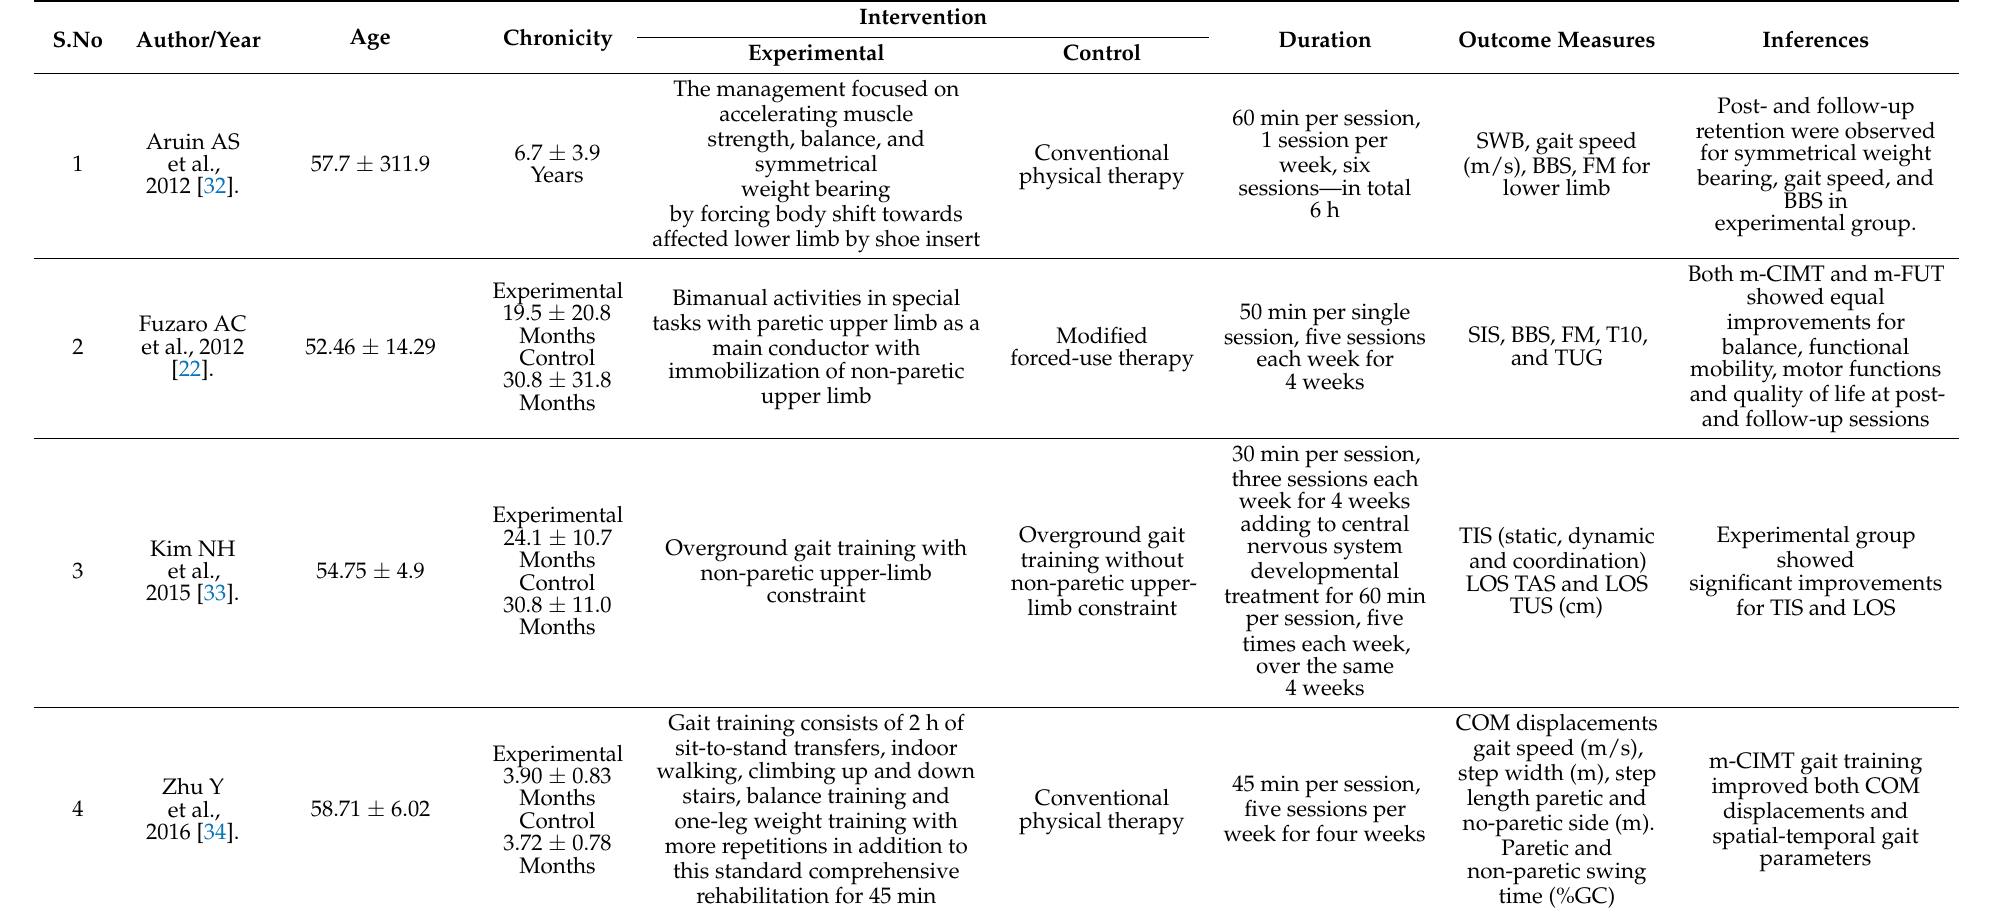
Table 3. Characteristics of studies on constraint-induced movement therapy